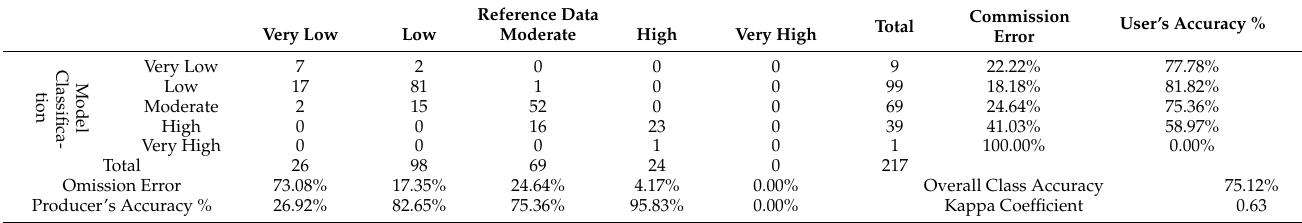
Table 6. Accuracy error matrix for flood index vulnerability